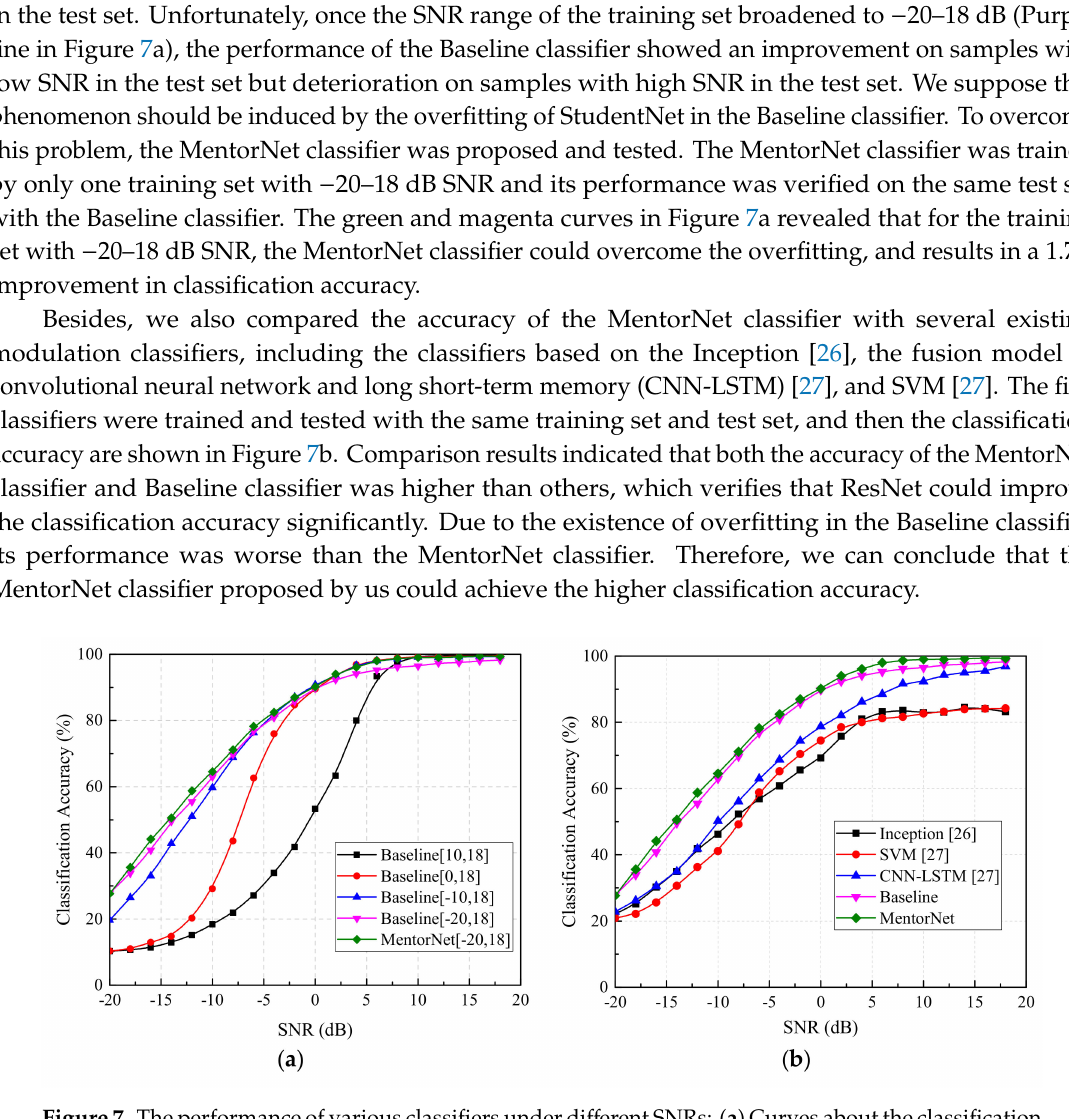
Figure 7. The performance of various classifiers under di ff erent SNRs: ( a ) Curves about the classification accuracy versus the SNR range of the training set, and ( b ) classification accuracy of di ff erent methods with − 20–18 dB